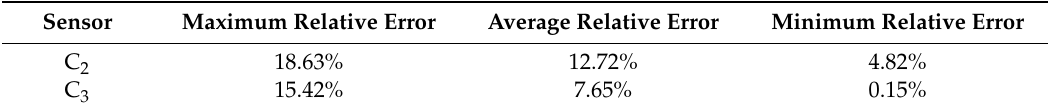
Figure 16. The temperature histories of C 2 during the multi-coil experiment and simulation. Table 6. Comparison of simulation and experiment.